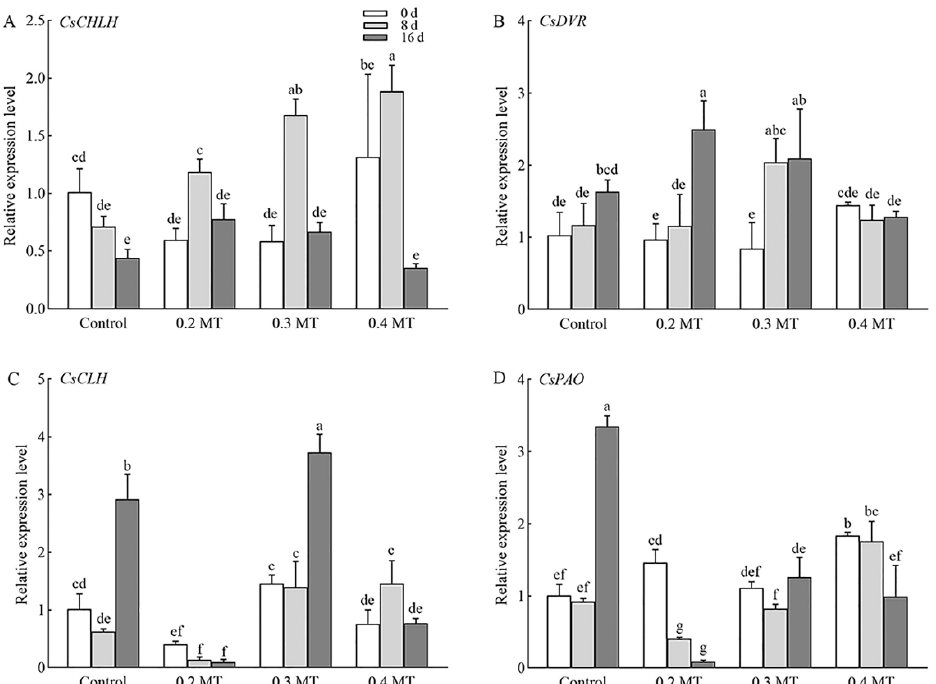
Figure 9. Expression validation based on RT-qPCR of genes involved in Chl metabolism. ( A ) CsCHLH ; ( B ) CsDVR ; ( C ) CsCLH ; ( D ) CsPAO . Data are shown as means ± SD in three independent replicates. Different superscript letters indicate significant differences between different treatments at p < 0.05 level.